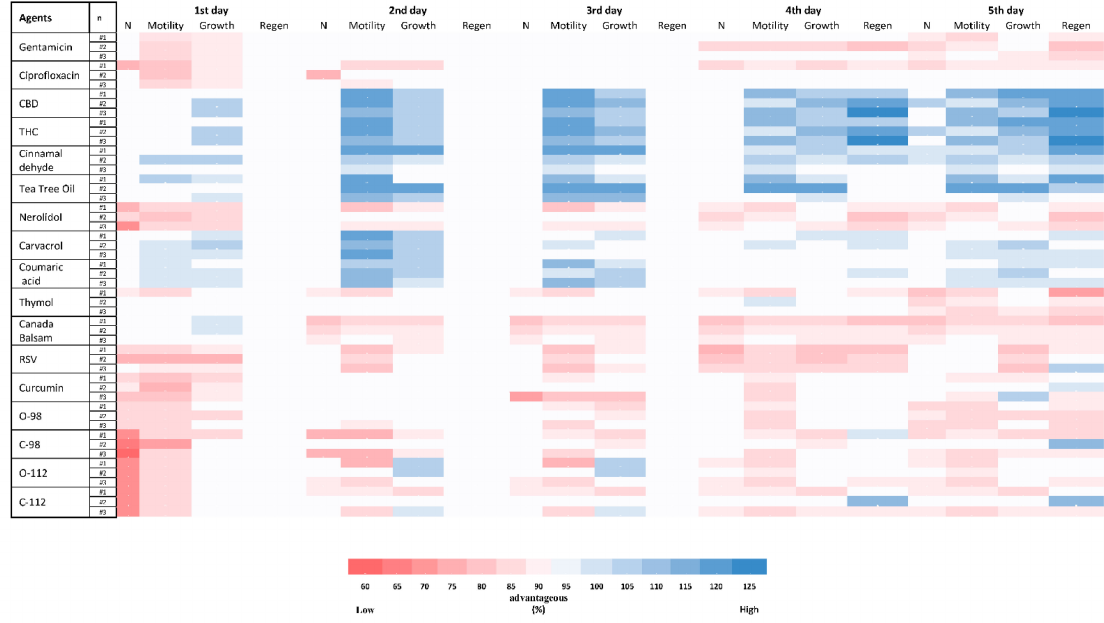
Figure 4. Heatmap on survival ratio of C. elegans and toxicity of the 15 different plant-based natural compounds (PBCs) as an antibacterial agent in the C. elegans model. All treated groups with PBCs were compared with the untreated group and the results are reported in the ratio (%). The red colour shows the lower advantage and the groups with the blue colour had the higher advantage in comparison with the control group. n = number of trials; N = number of animals; Regen =